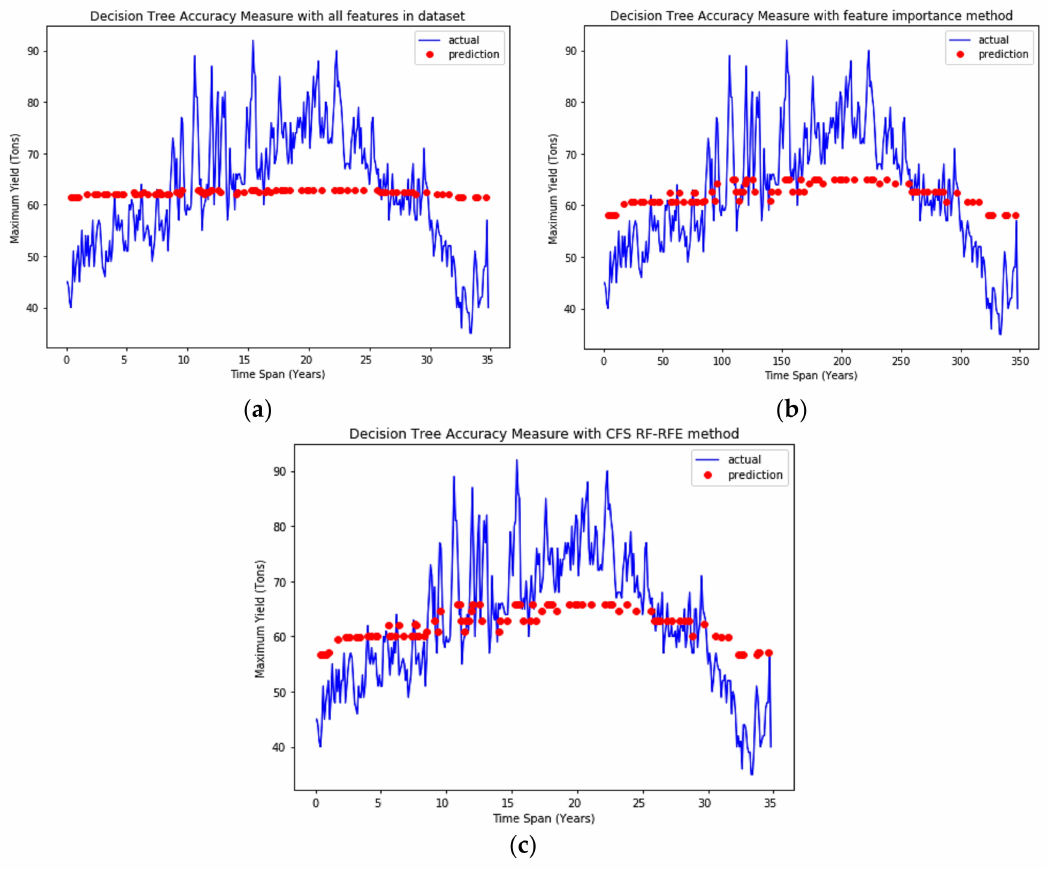
Figure 7. Decision-tree model accuracy measure using: ( a ) proposed CFS RF-RFE feature selection method, ( b ) algorithm in-built feature importance method, ( c ) all the features in the